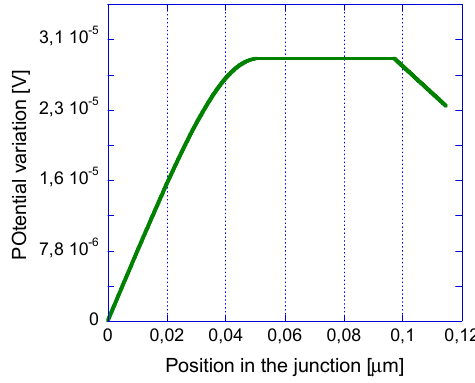
Figure 4. The distribution of the self-mixing potential within the junction.